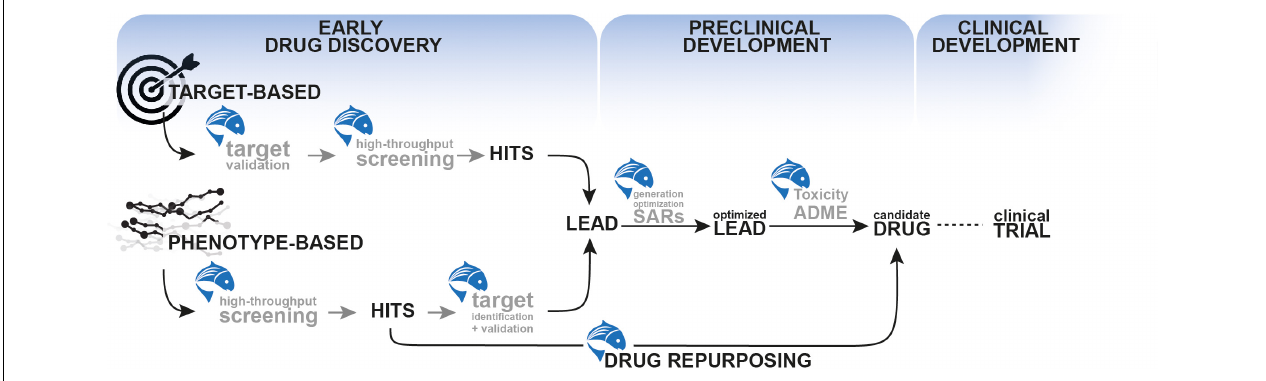
FIGURE 2 | The use of zebrafish as a predictive preclinical model to accelerate various stages of drug development, from early discovery to preclinical